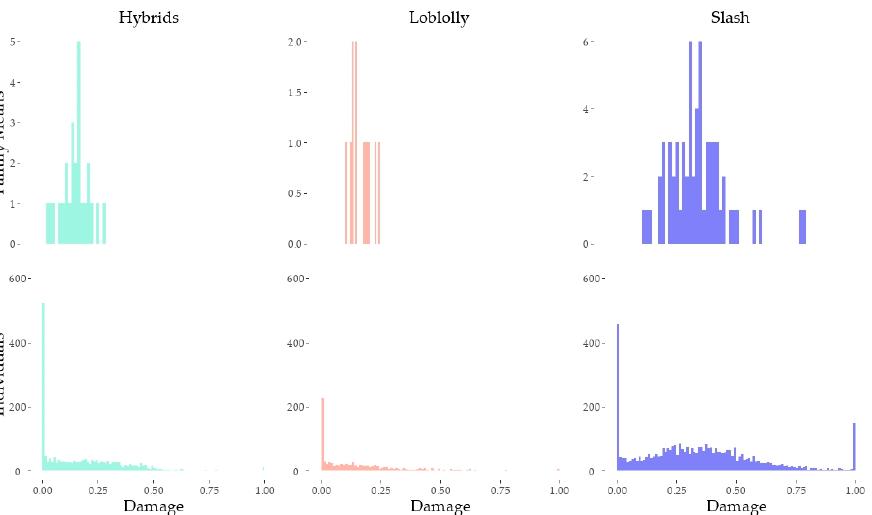
Figure 3. Histogram of individual and raw family mean damage stratified by taxon. This histogram includes all data including records identified as potential escapes.